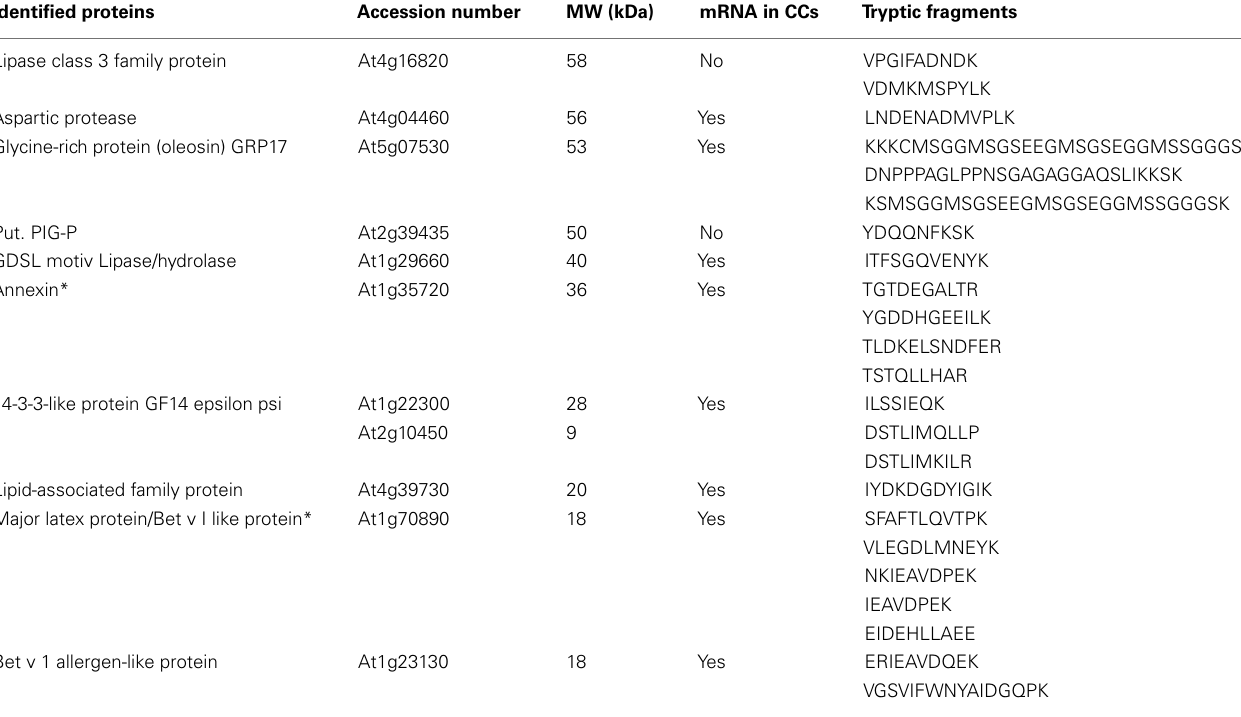
Table 1 | Lipid-binding proteins identified in Arabidopsis thaliana phloem